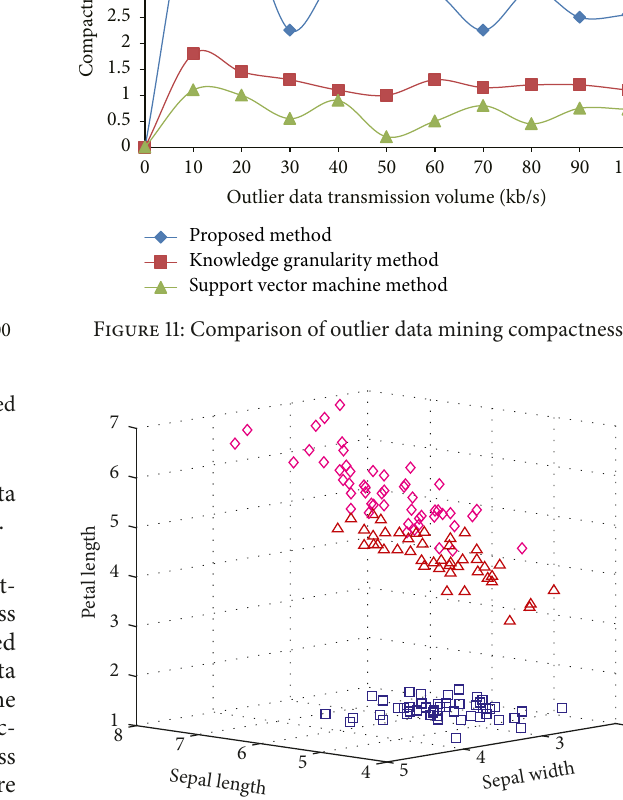
Figure 12: Clustering results of outlier